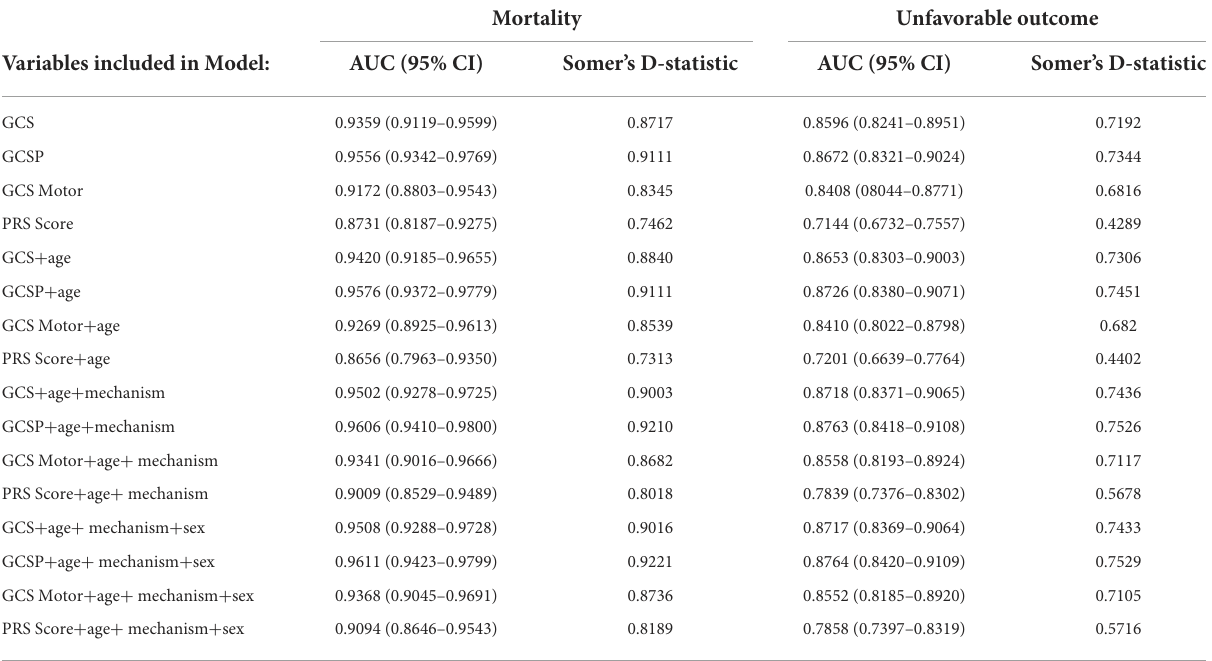
TABLE 3 Predictive accuracy [Area Under the Curve (AUC) of the Receiver Operator Characteristic].